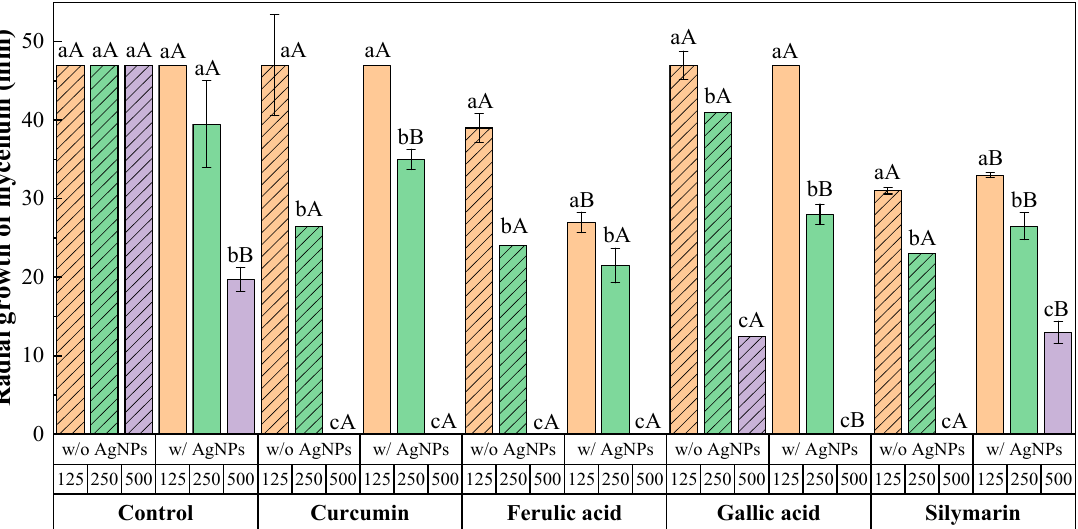
Figure 1. Radial growth values of P. cinnamomi mycelium in the presence of the conjugates, composed of various polyphenol inclusion compounds with (w/) or without (w/o) silver nanoparticles (AgNPs) [14] at different concentrations (in µg·mL − 1 ). For each treatment, concentrations labelled with different lowercase letters are significantly different at p < 0.05 by Tukey’s test. For treatments with the same polyphenol and at the same dose, different uppercase letters indicate that the absence/presence of AgNPs resulted in significant differences at p < 0.05 by Tukey’s test. Mean values of three experiments with three replicates are presented, with error bars representing the standard deviation. Table 1. Effective concentrations of the conjugates that inhibited mycelial growth by 50% and 90% (EC 50 and EC 90 , respectively).